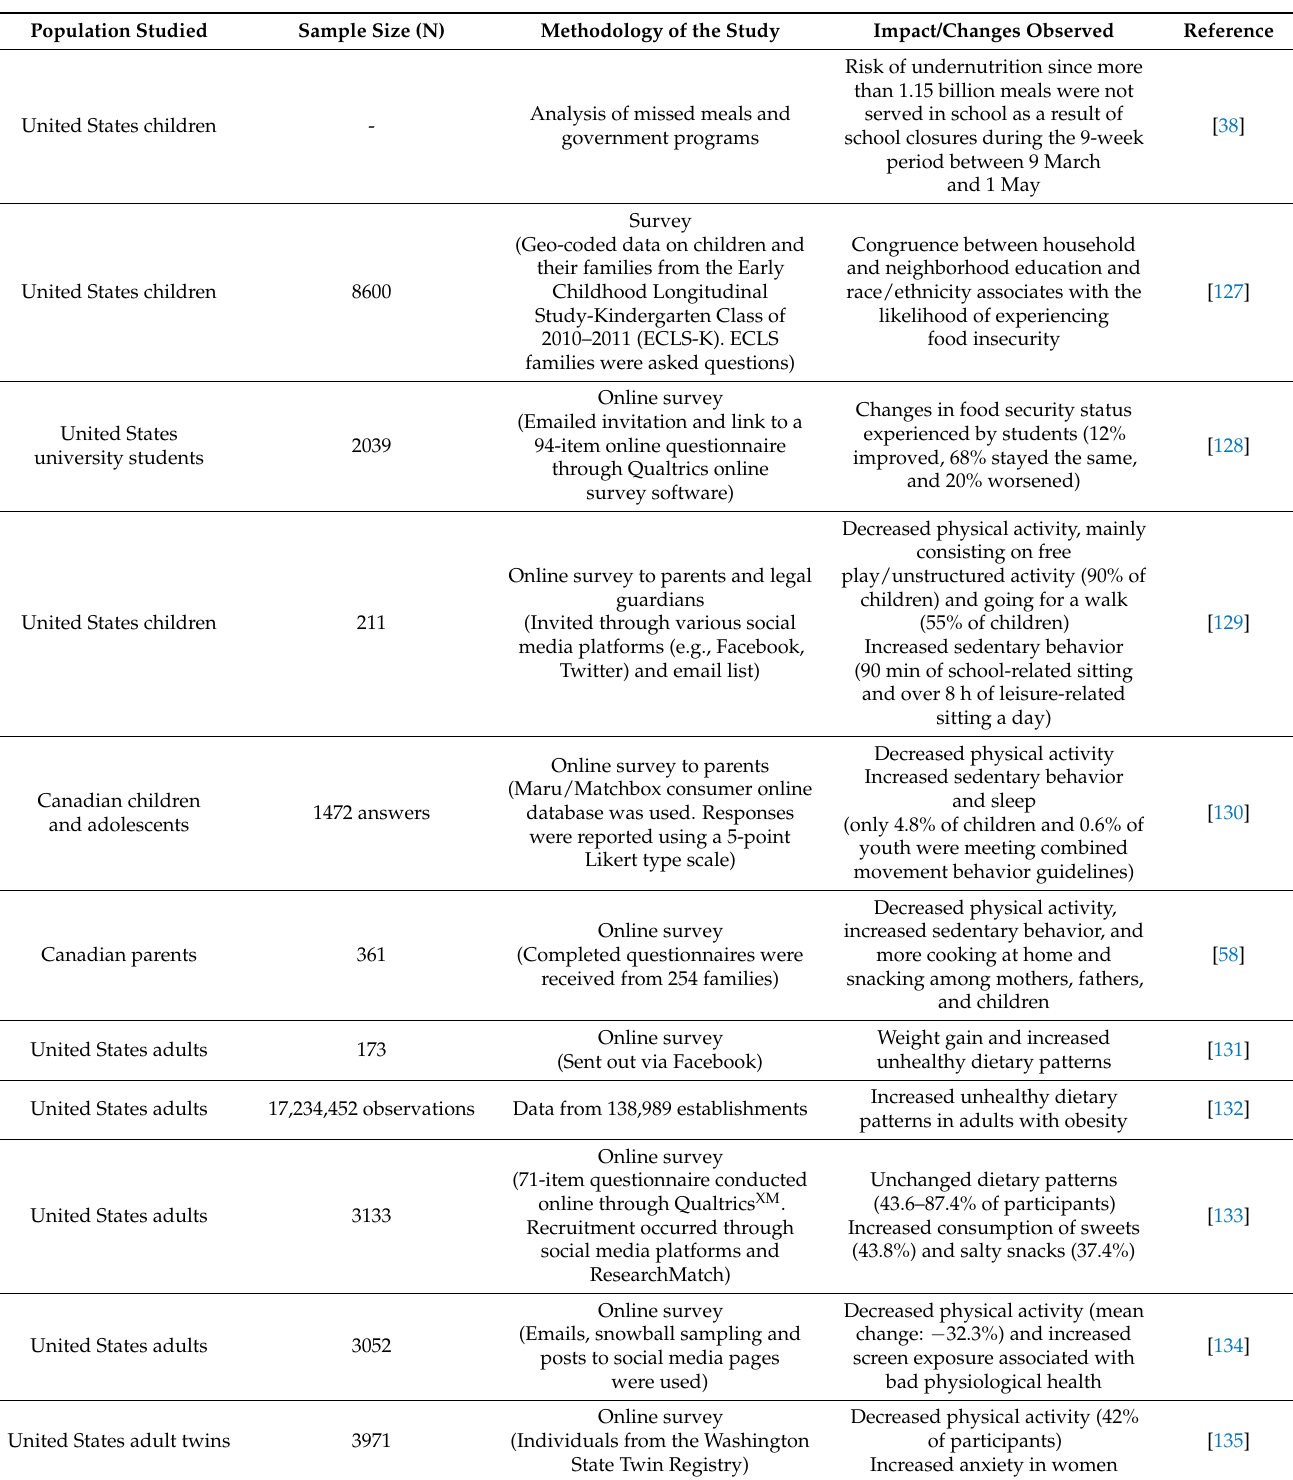
Table 4. Brief summary of studies related to the consequences of the lockdown in North American